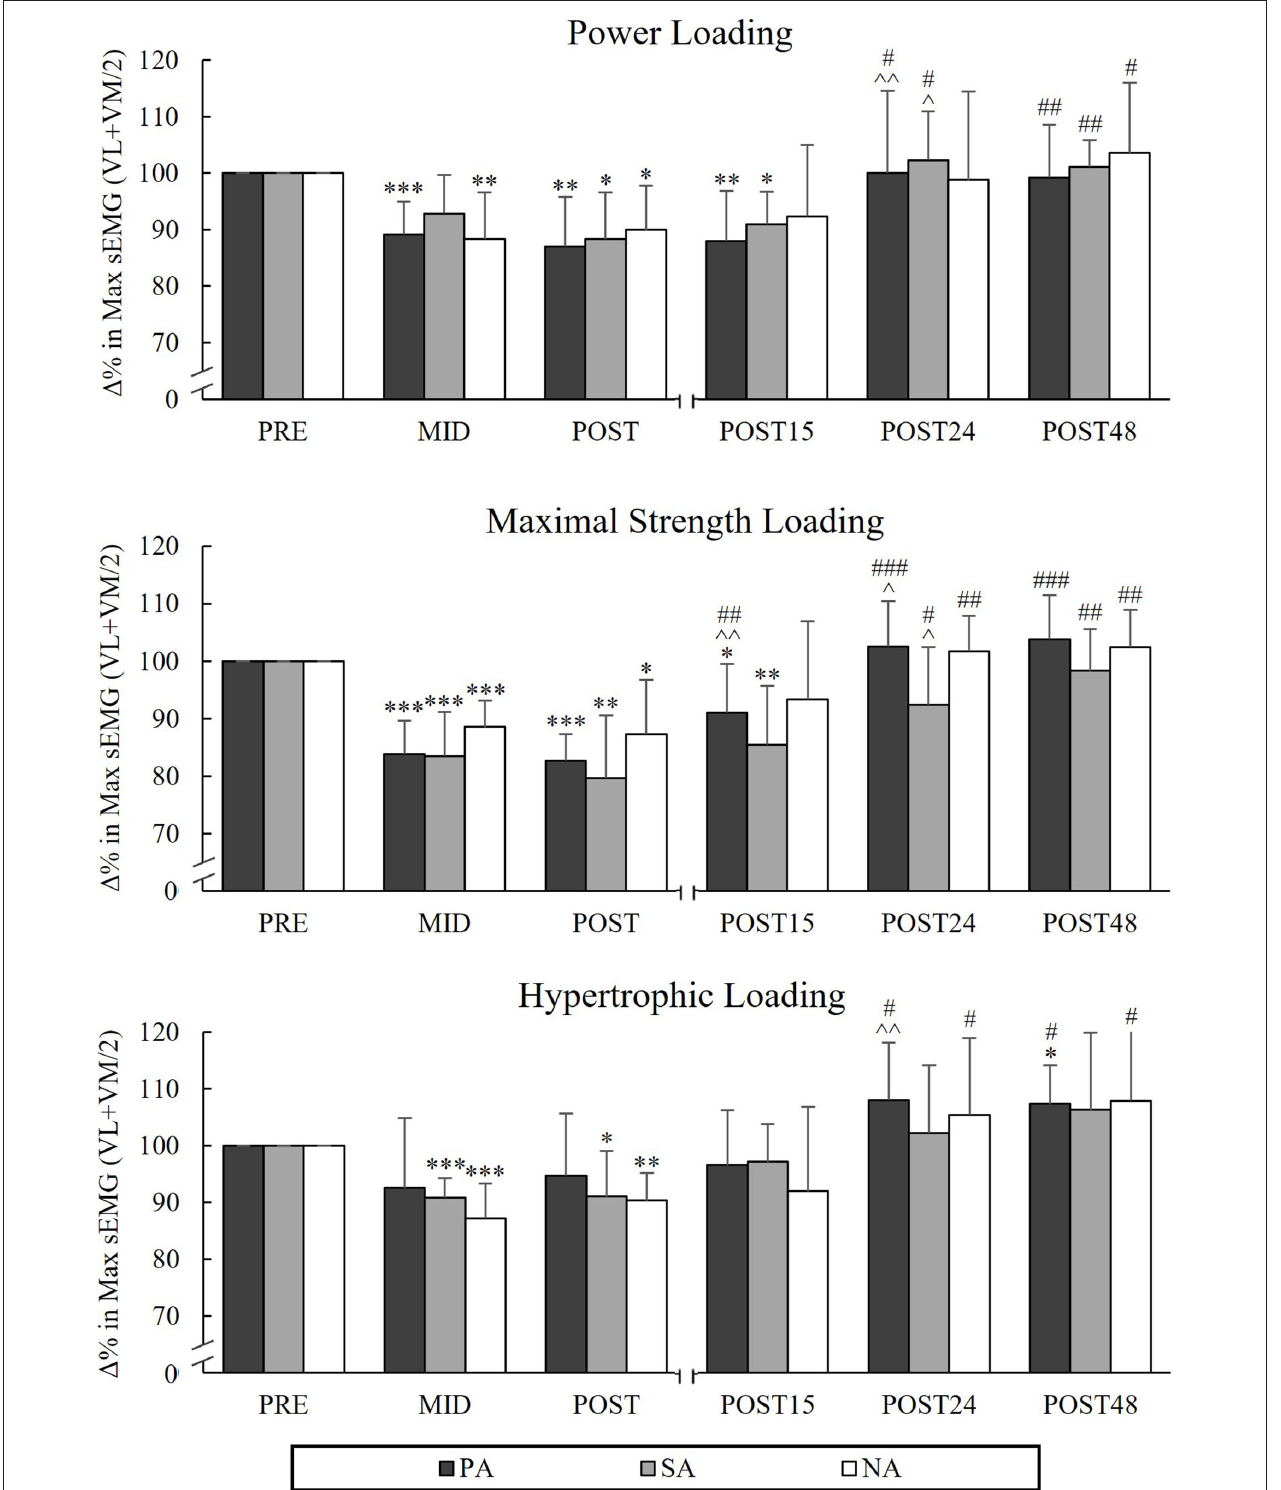
FIGURE 3 | Relative changes in maximal averaged sEMG values of VL and VM muscles in isometric leg press during three resistance exercise loadings in power (PA), strength (SA), and non-athletes (NA). * p < 0.05, ** p < 0.01, *** p < 0.001 refer to within-group significances compared to Pre. ∧ p < 0.05, ∧∧ p < 0.01 refer to within-group significances compared to the previous time point. # p < 0.05, ## p < 0.01, ### p < 0.001 refer to within-group significances compared to Post during recovery.